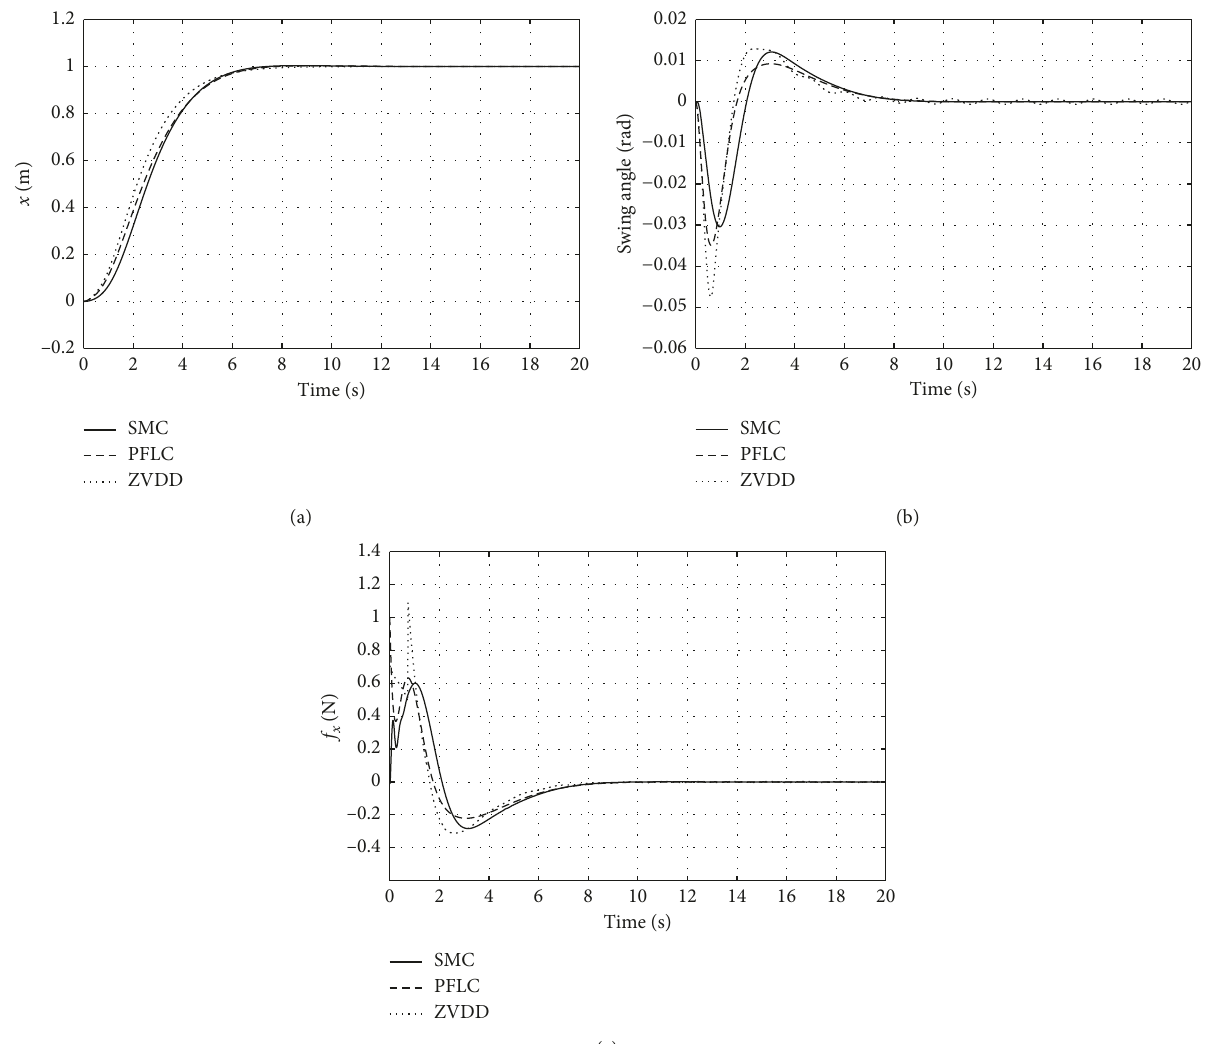
Figure 8: Quadrotor’s position along the X -axis, pendulum swing angle, and force f ZVDD controllers for l � 0.5m and m �